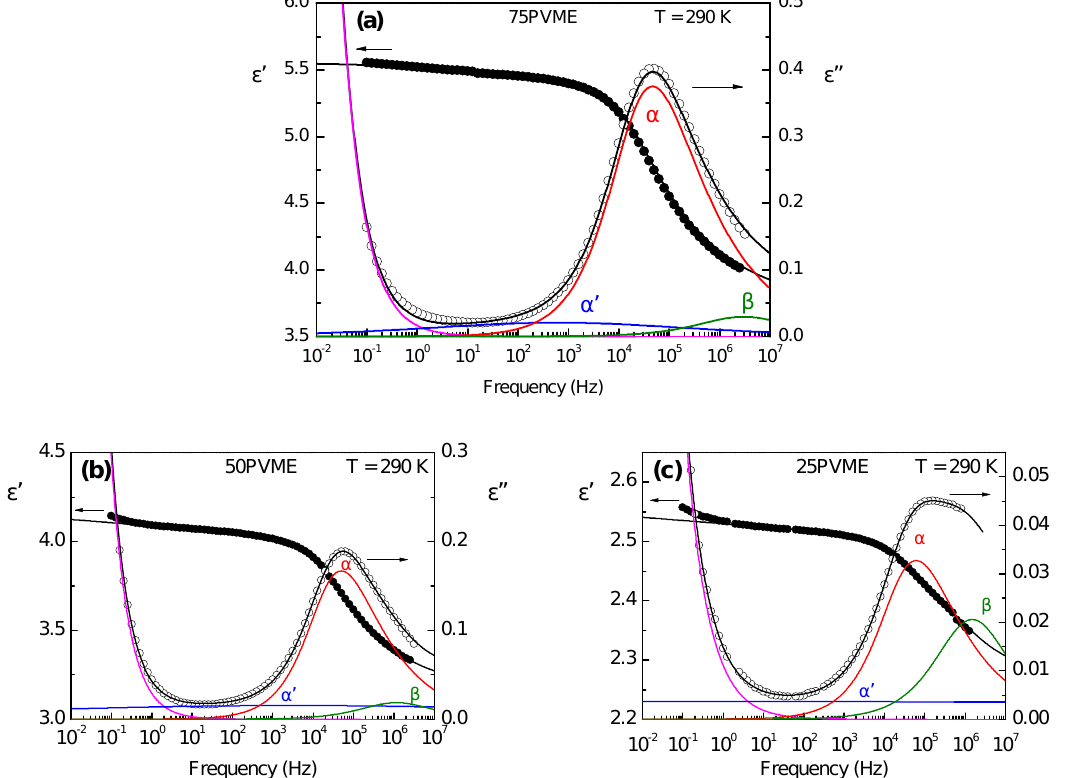
Figure 8. Dielectric spectra of ( a ) 75PVME, ( b ) 50PVME, and ( c ) 25PVME at T = 290 K. Solid black lines are the fitting curves obtained by the addition of α -relaxation (red), an additional slow process (blue), β -relaxation (green), and DC-conductivity contribution